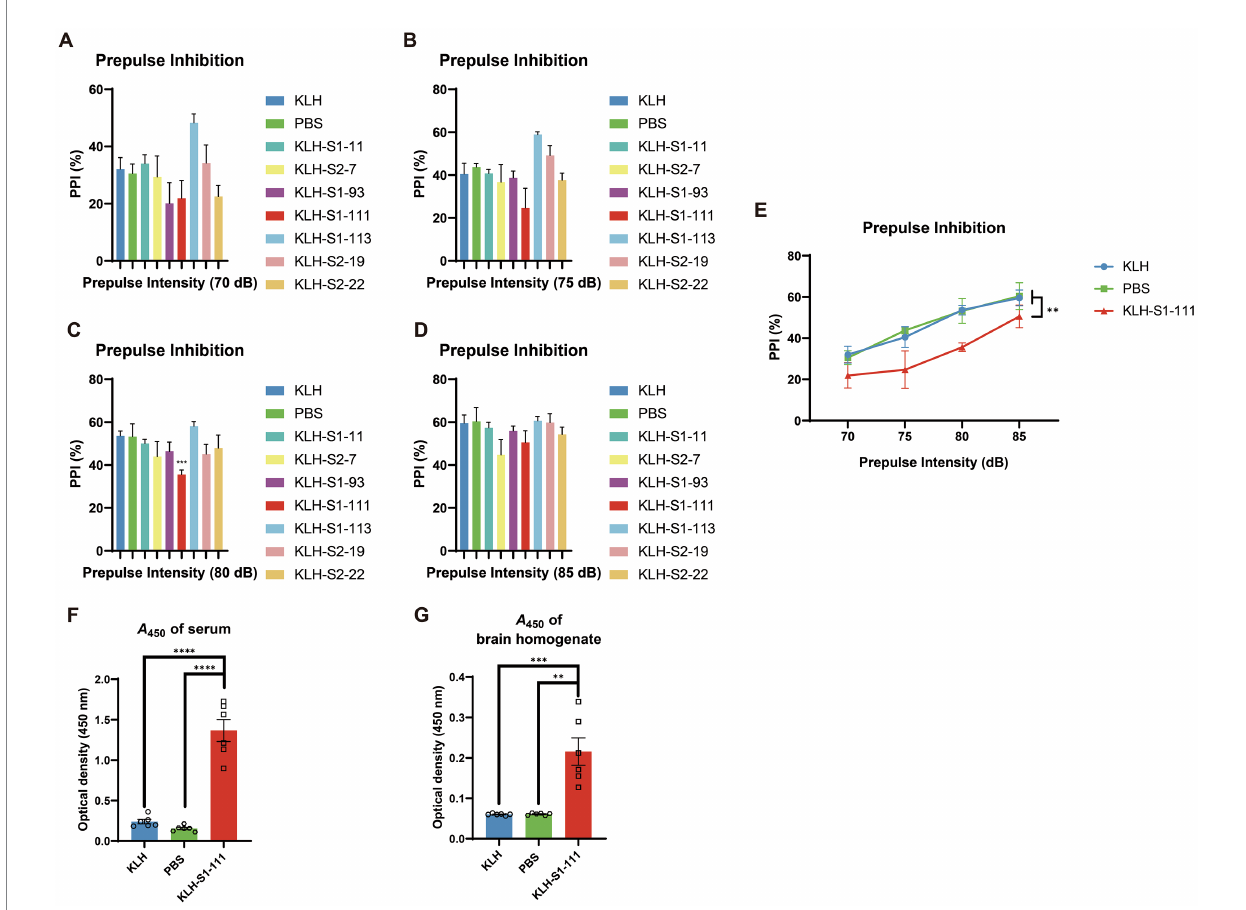
FIGURE 2 Detection of PPI and antibody levels in immunized ApoE −/− mice. (A–D) The results of the PPI test at different dBs, and the PPI reduction in K-S mice was significant at 80 dB (unpaired Student’s t test, p = 0.0004). (E) A significant reduction in % PPI (two-way ANOVA, p = 0.0011) was found in K-S mice compared with KLH-immunized mice ( N = 5/group). (F–G) Increased anti-S1-111 IgG levels were measured in serum (unpaired Student’s t test, p < 0.0001) and brain homogenate (unpaired Student’s t test, p = 0.001) of K-S mice compared with KLH-immunized mice. N = 6/group, unpaired Student’s t test. (A–G) . Data are shown as the mean ±